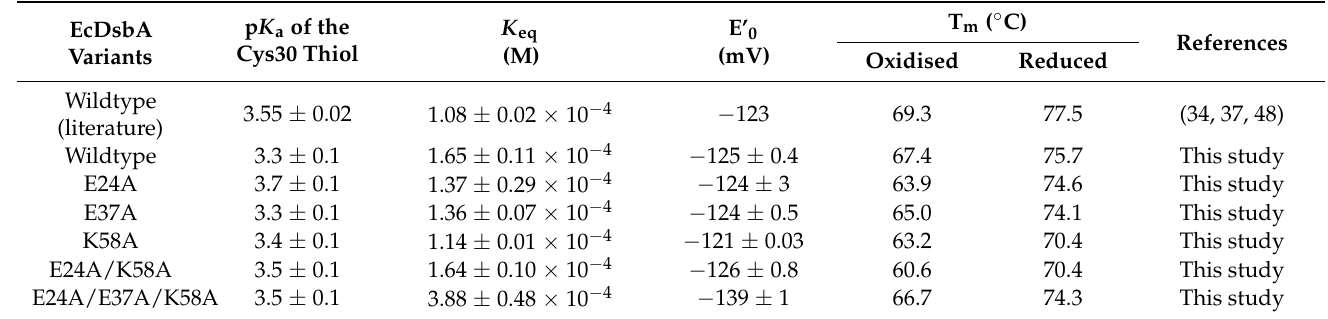
Table 1. Redox and biochemical parameters of DsbA mutants. p K a and K eq are expressed as mean ± standard error of the mean (SEM) with at least three independent